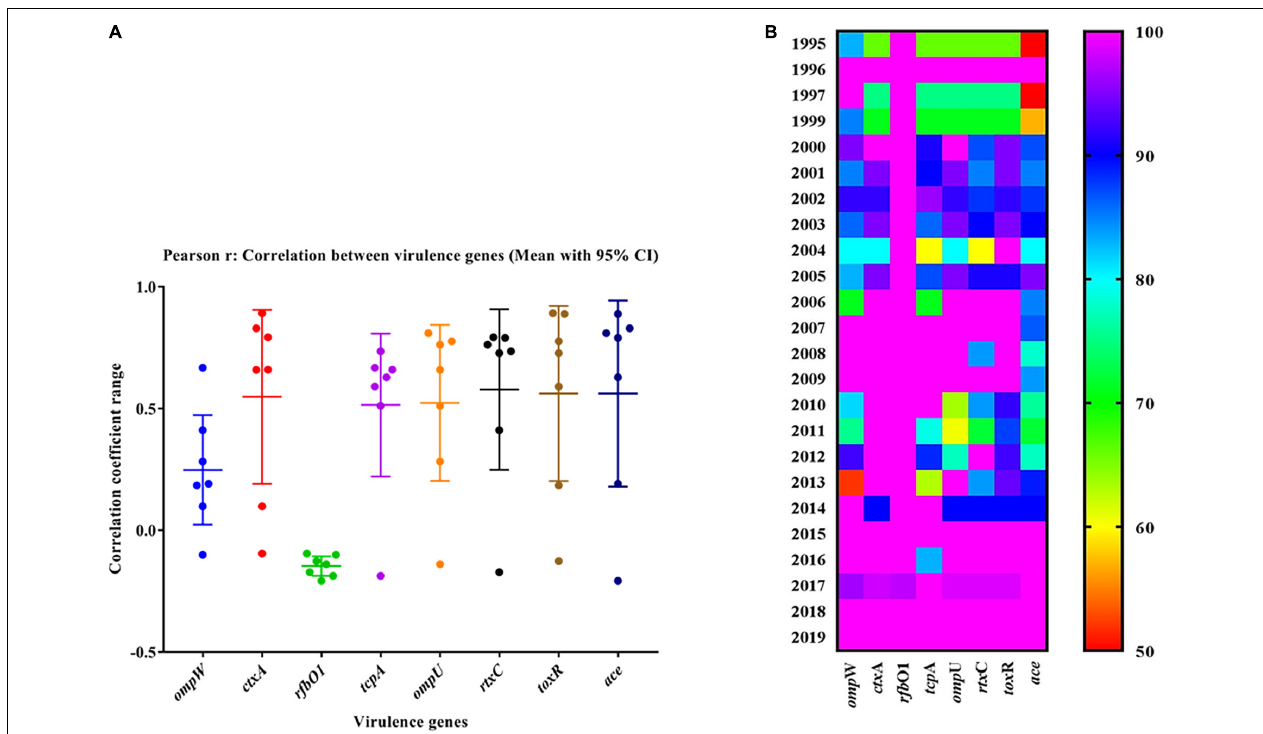
FIGURE 3 | (A) Scatter plot of the correlation between virulence genes of Vibrio cholerae O1 strains. The data represent different magnitudes of correlation coefficient (r) ranges between –0.5 and 1.0. A positive correlation indicated a stronger association between the variables and vice versa. The greater the absolute value of the Pearson product–moment correlation coefficient, the stronger the linear relationship. (B) Heat map showing the percentage variation in different virulence-associated genes distributed among the strains in different